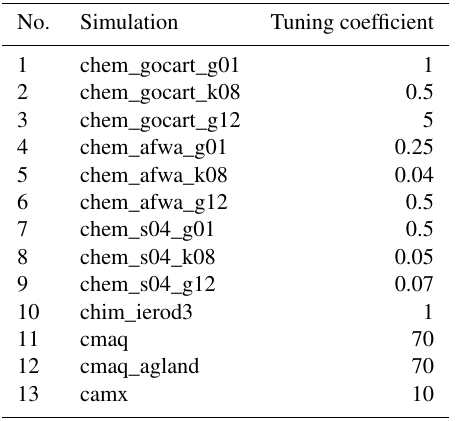
Table 3. Simulations used for validation and their corresponding tuning